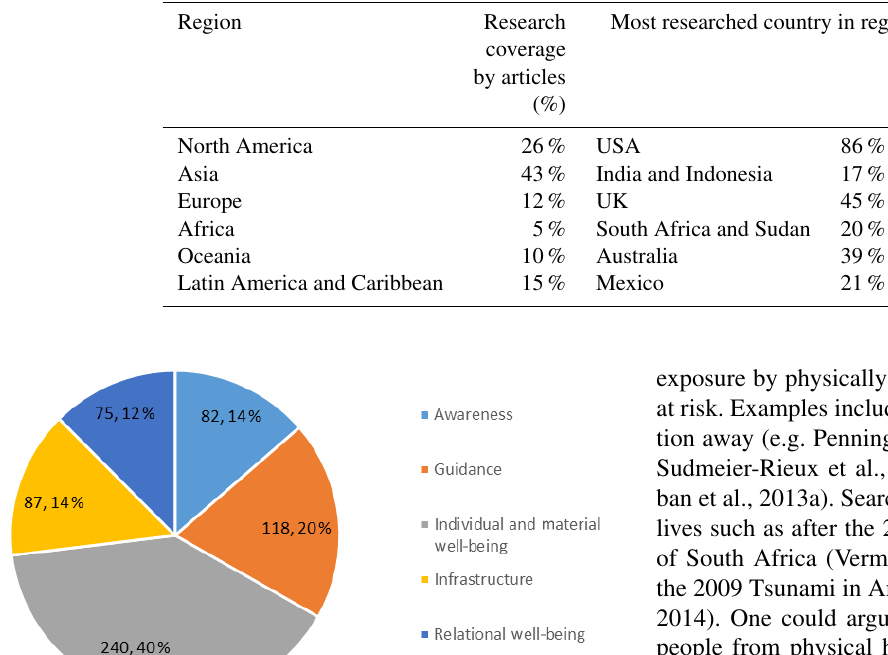
Table 2. Spatial coverage of studies (188 articles). Research coverage represents the proportion of articles that address responses in that re- gion. The values exceed 100% because countries are covered by more than one study. Research coverage by region represents the proportion of countries within a region covered by the reviewed studies. (In other words, if all countries of a region were represented in our sample, coverage would be 100%.)